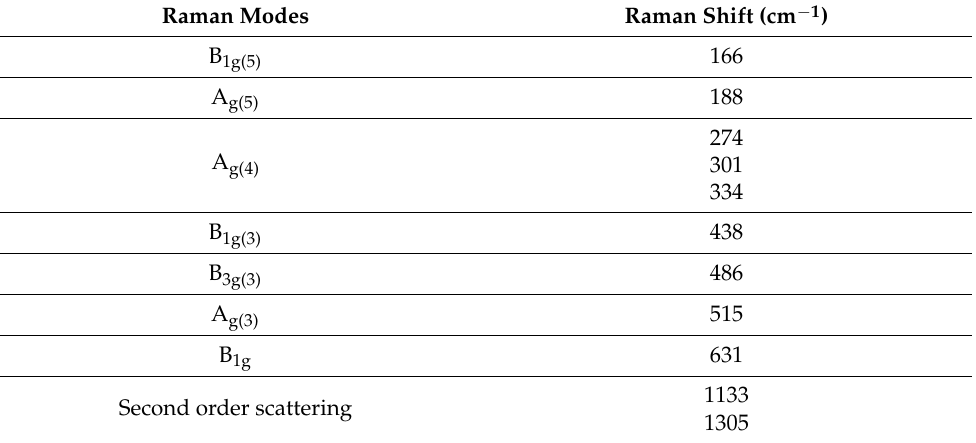
Figure 6. Raman spectrum of phase-pure LaFeO 3 at room temperature. Table 1. Position of Raman modes and their assignments for the phase-pure LaFeO 3 compound prepared by RFS.